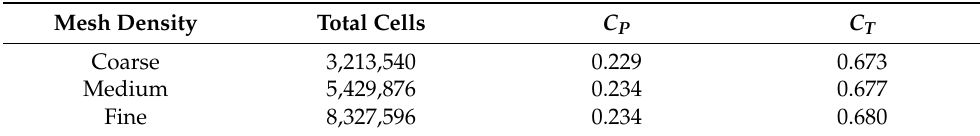
Figure 6. Mesh distribution on the surface and near the central x − y plane of ASWT rotor. Table 1. Mesh independence